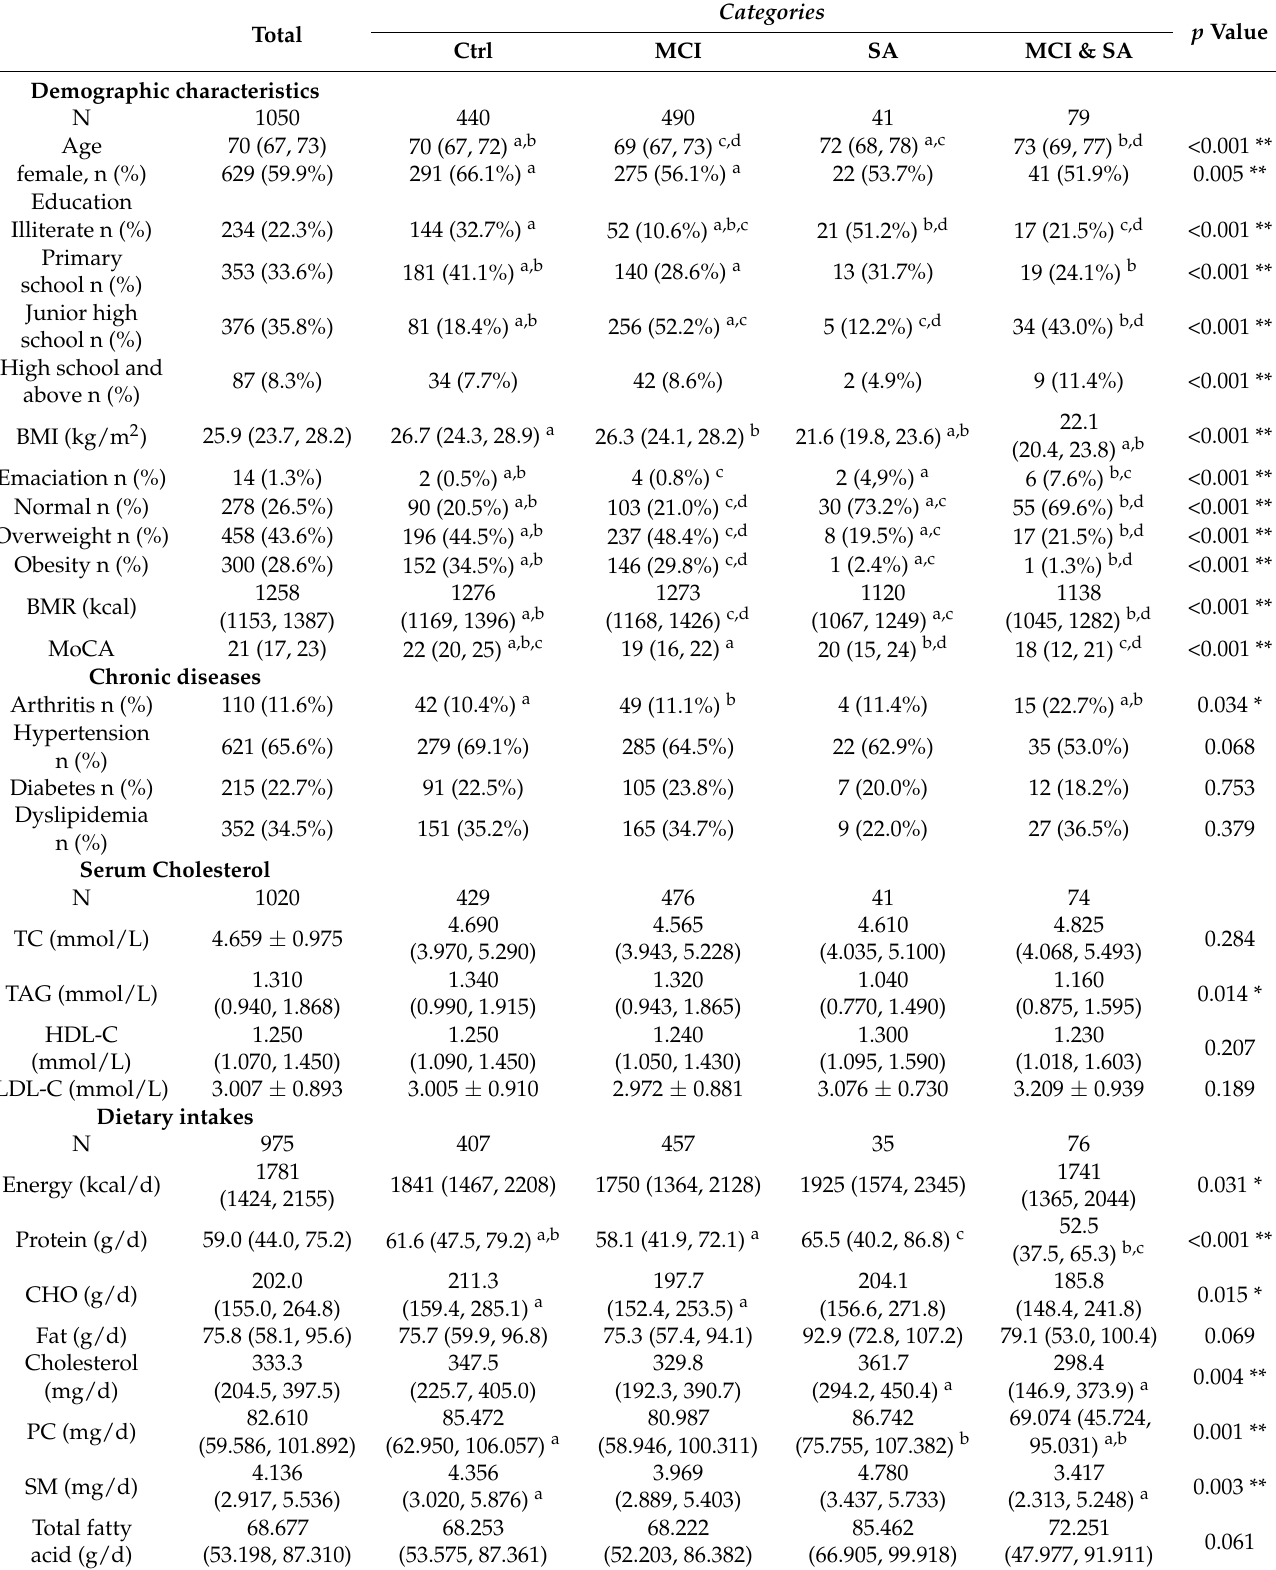
Table 1. Demographic and clinical characteristics of